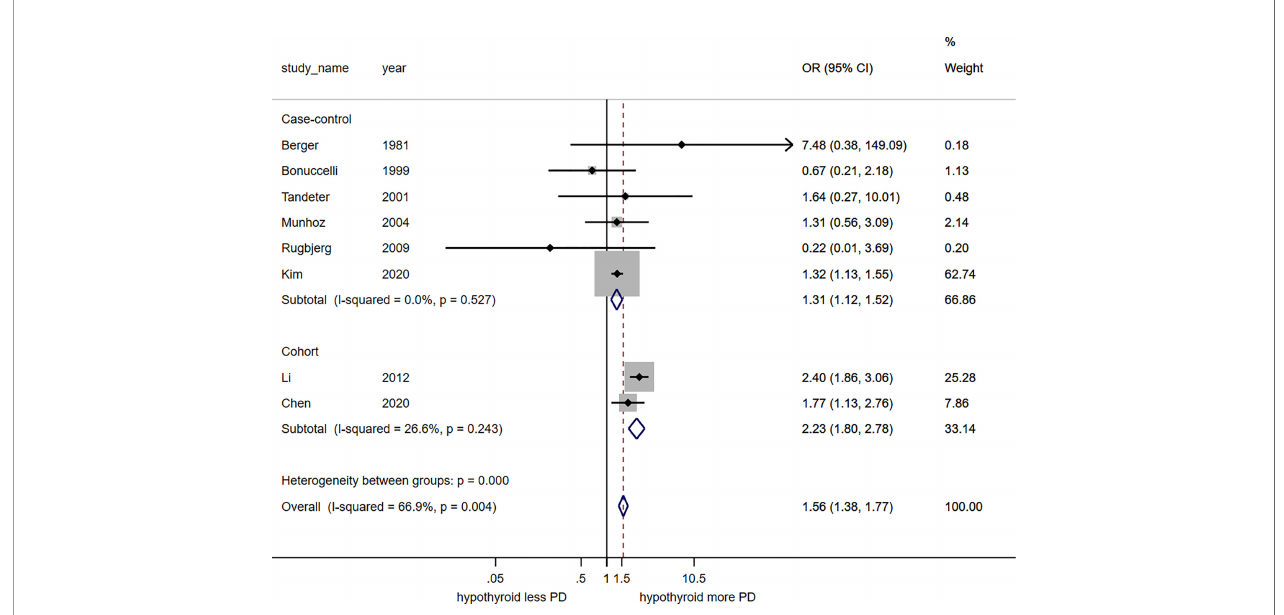
FIGURE 2 | Forest plot of the meta-analysis of risk of Parkinson ’ s disease in patients with